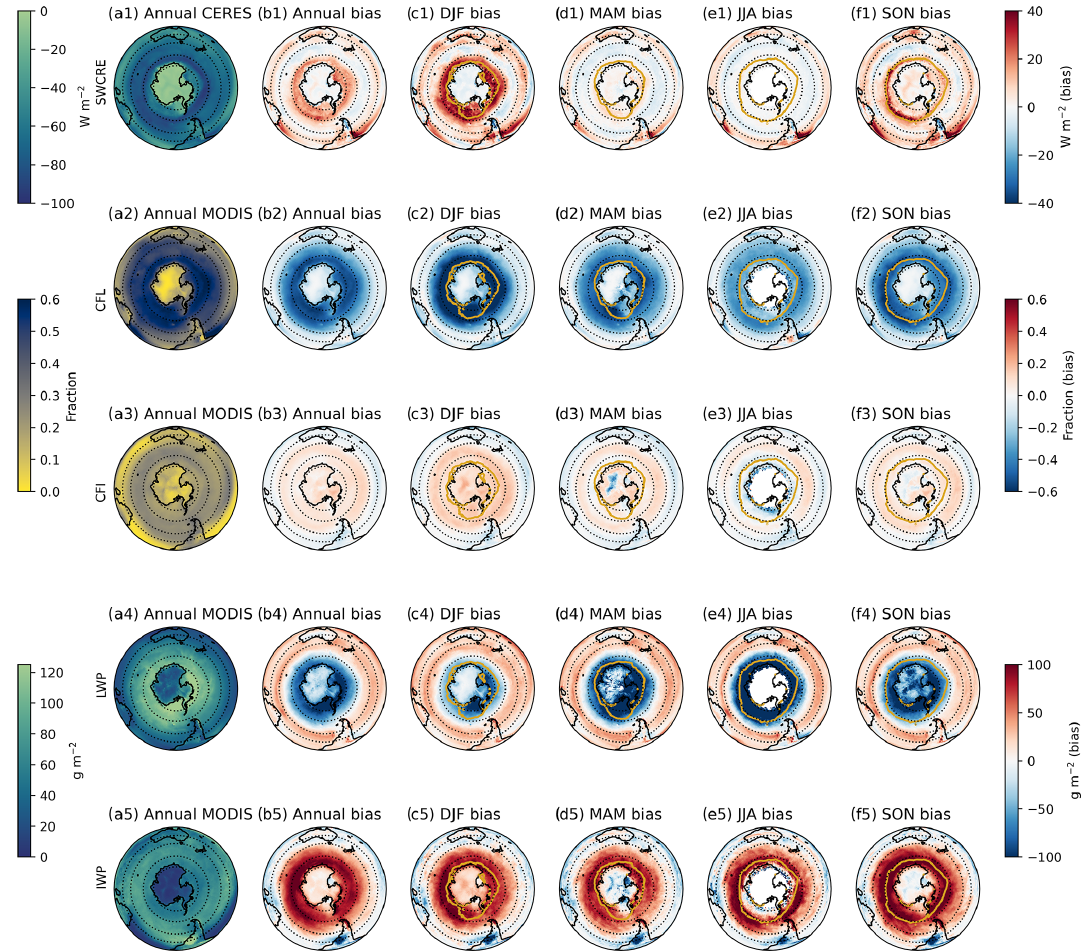
Figure 1. Column (a) shows the annual mean satellite (CERES-SYN1deg or MODIS)-derived field for row 1, SWCRE TOA (Wm − 2 ); row 2, CFL; row 3, CFI; row 4, LWP (gm − 2 ); and row 5, IWP (gm − 2 ); column (b) shows annual biases (ACCESS-AM2 − satellite) in the same respective fields; columns (c) – (f) show seasonal biases (DJF, JJA, MAM, SON). The yellow line in columns (c) – (f) shows the mean seasonal extent of sea ice (calculated at 15% coverage), taken from the Hurrell et al. (2008) AMIP sea ice concentration data set. Dashed lines are located at 30, 43, 58 and 69 ◦